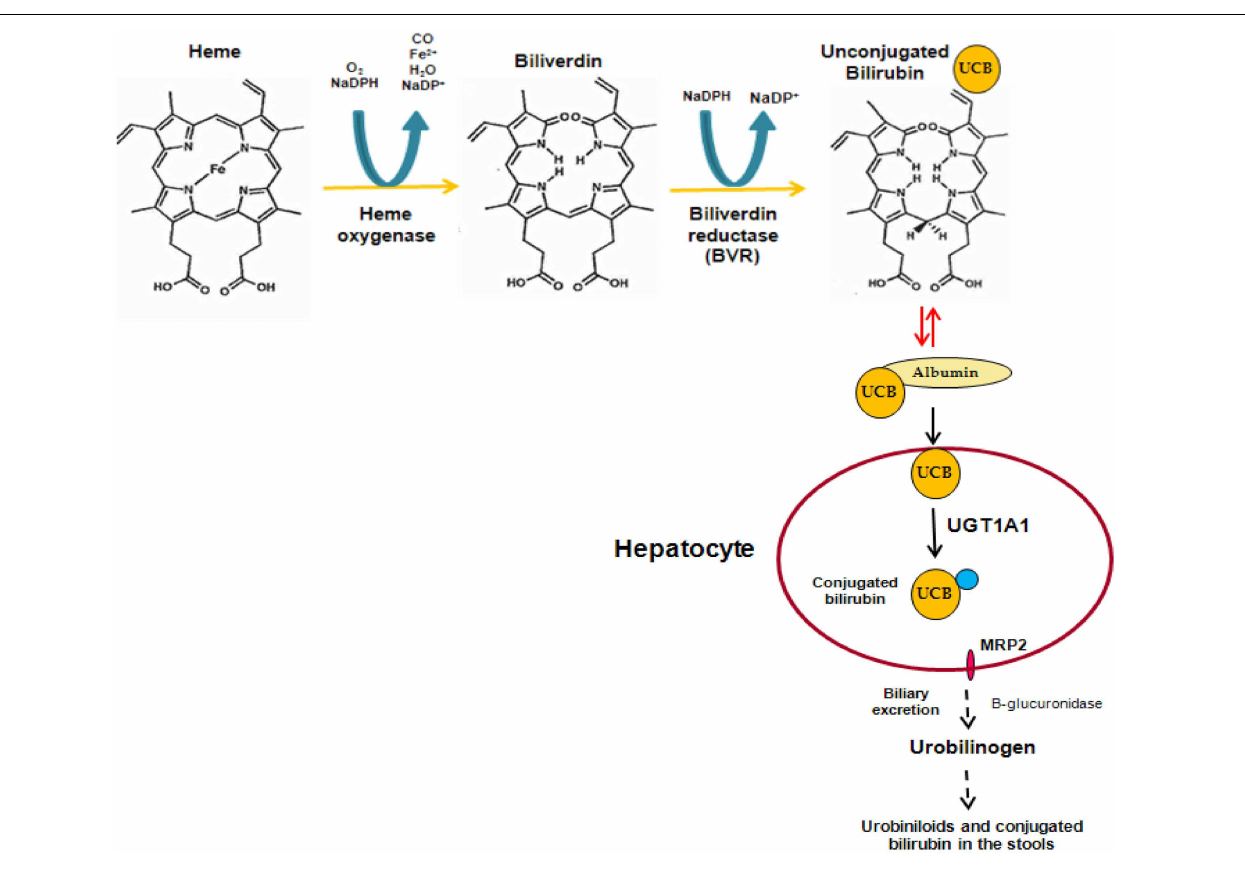
FIGURE 1 | Formation and elimination of unconjugated